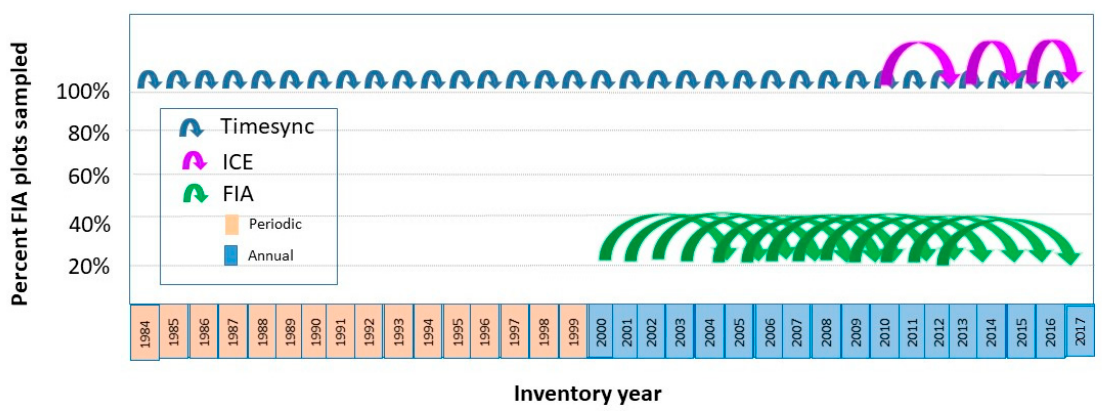
Figure 2. The percentage of plots in FIA’s quasi-systematic grid that were sampled under each of the three land use and land cover change observation systems by year pairings. Percentages on the y -axis indicate the proportion of the population sampled at each time step ( x -axis). Older periodic inventories conducted by FIA are not included in these analyses.